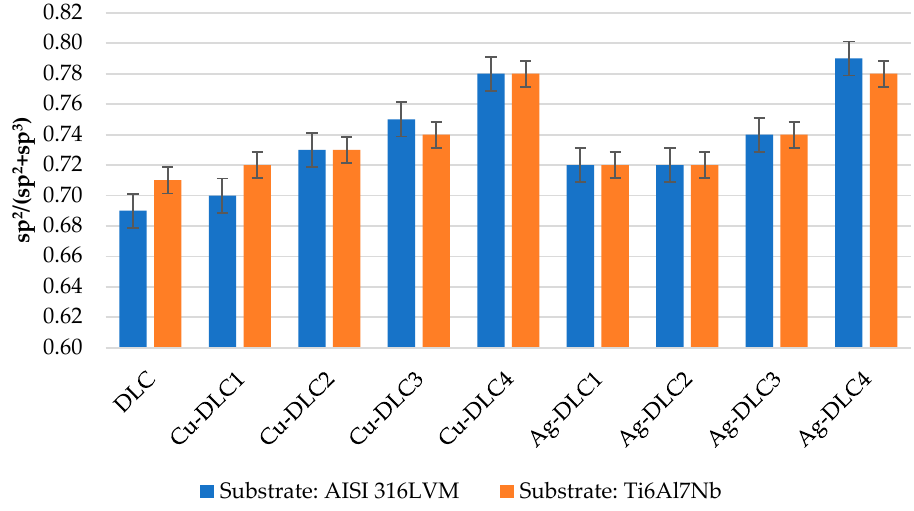
Figure 3. The sp 2 /(sp 2 + sp 3 ) ratio calculated on the basis of deconvolution of C1s peak.